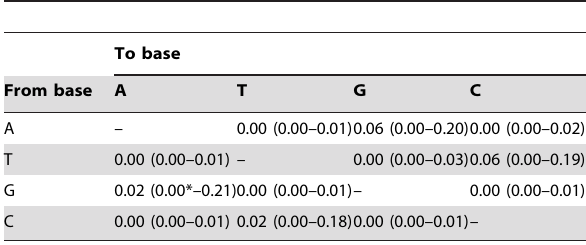
Table 2. Frequency of specific nucleotide substitution errors in raw UDPS data.